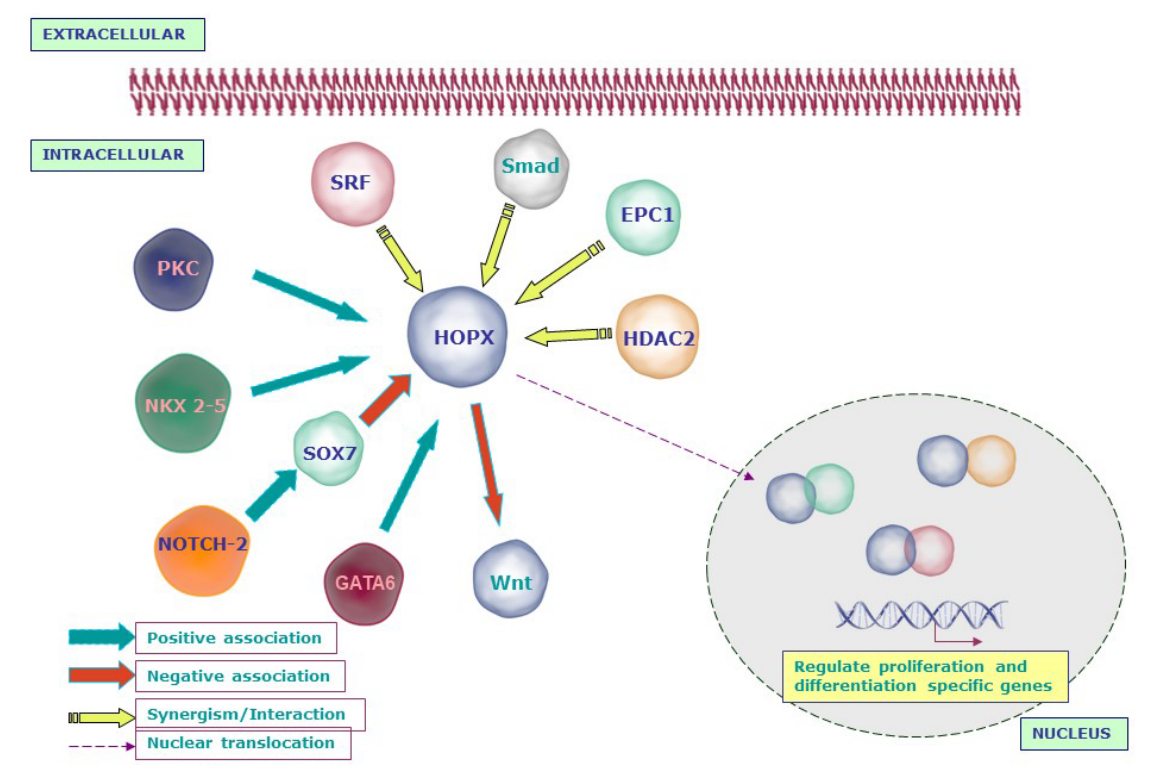
Figure 2. Schematic representation of the molecular networks regulated by HOPX in development: HOPX is activated by the signaling molecules that are essential for normal development such as NKX2-5, PKC, and GATA6. However, NOTCH2 inhibits HOPX through SOX7. HOPX interacts with serum response factor (SRF) and inhibits SRF-mediated transcription. On the other hand, HOPX recruits histone deacetylase 2 (HDAC2) to modulate the function of SRF. Apart from SRF and HDAC, HOPX interacts with enhancer of polycomb 1 (Epc-1) to activate myogenin and induces myotube formation. During cardiomyogenesis, HOPX and Bmp signals synergistically inhibit Wnt signaling through activated Smads.